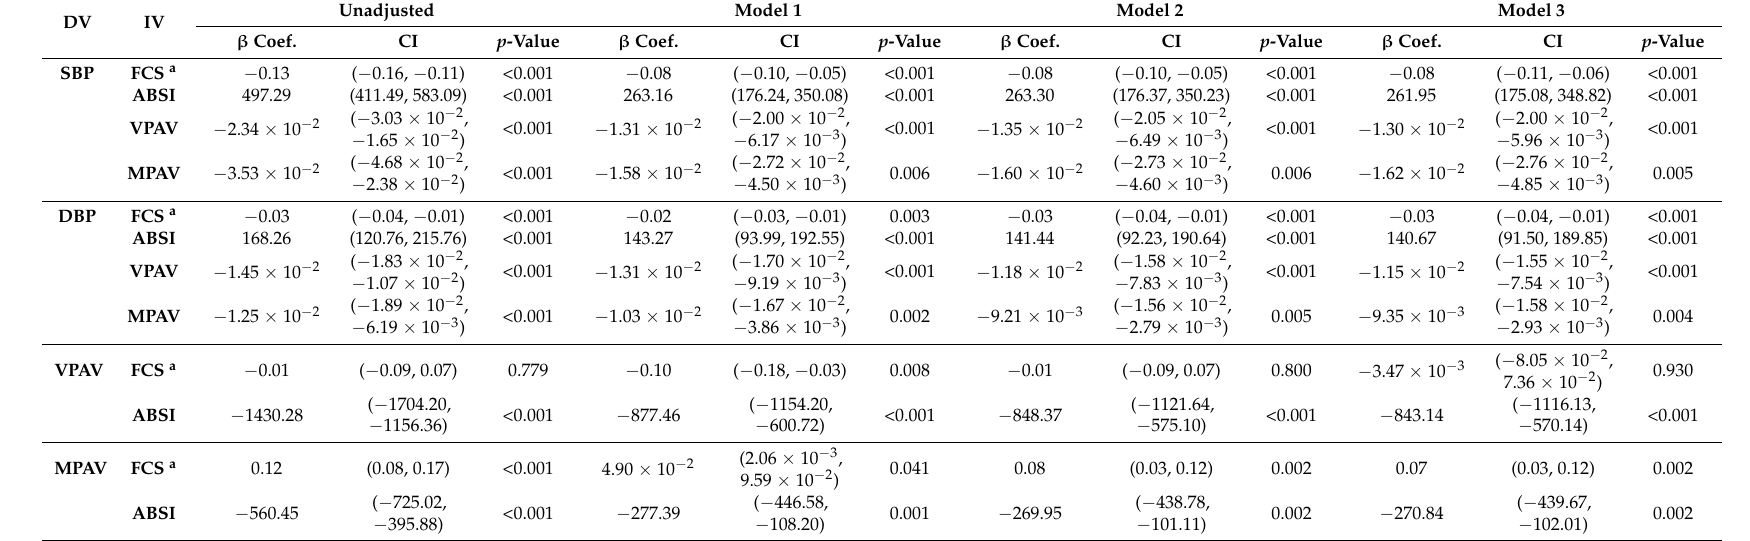
Table 3. General estimating equations (GEE) result between food consumption score, blood pressures, and physical